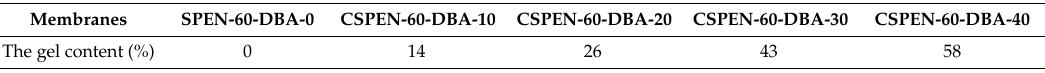
Table 2. The gel content of CSPEN-60-DBA-x with di ff erent propenyl group contents.